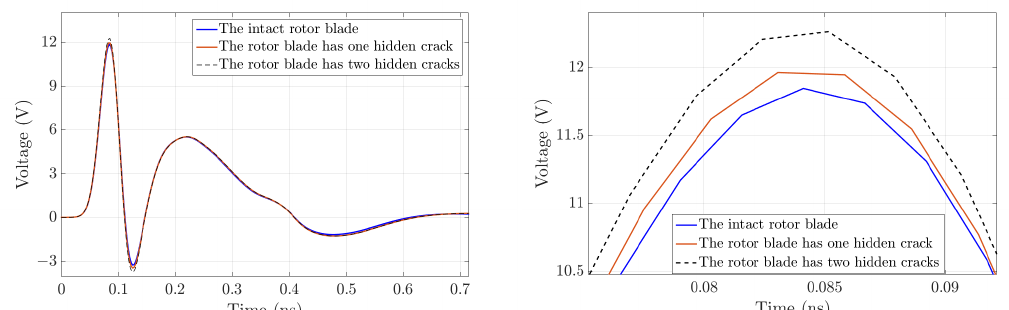
Figure 32. Comparison between the reflected voltage in the undamaged rotor blade and the hidden cracked rotor blades.